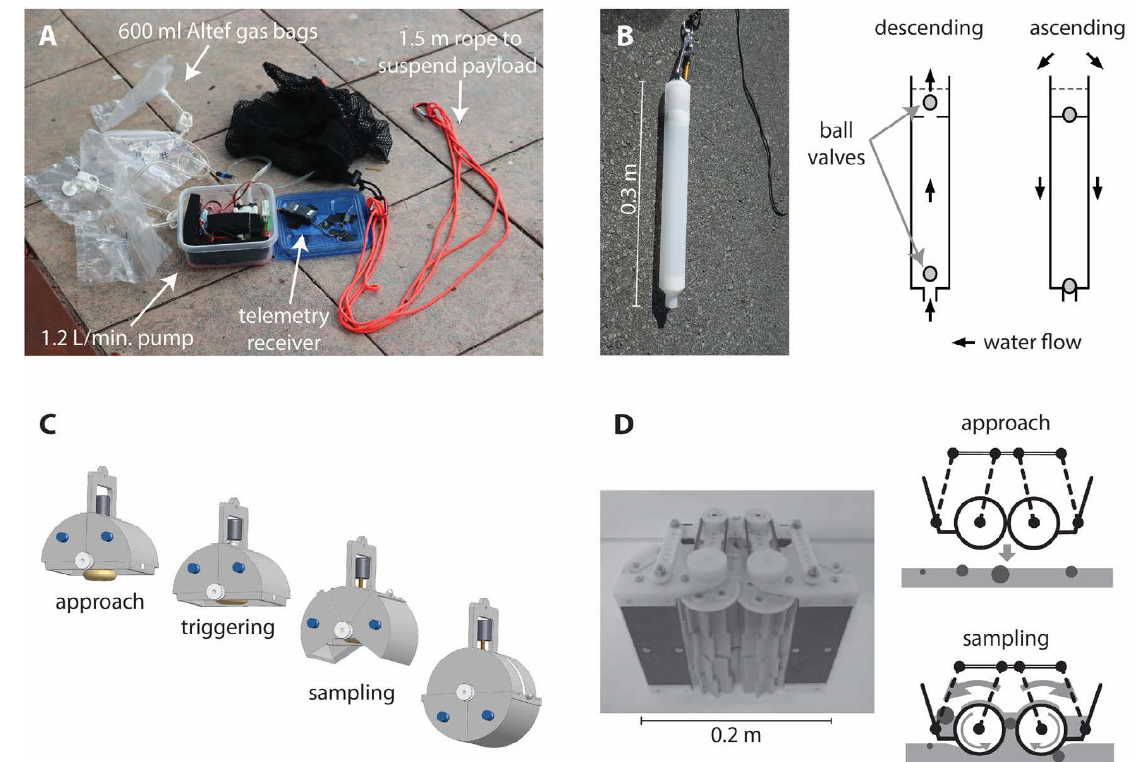
Figure 2: UAS-borne sample collection systems. [A] Gas sampling equipment. [B] Water sampler (left: photo- graph, right: cross-sectional schematic of sampling method; adapted from Terada et al. [2018] under the Creative Commons Attribution 4.0 International License). [C] ‘LUSI drone’ mud sampler conceptual diagram of